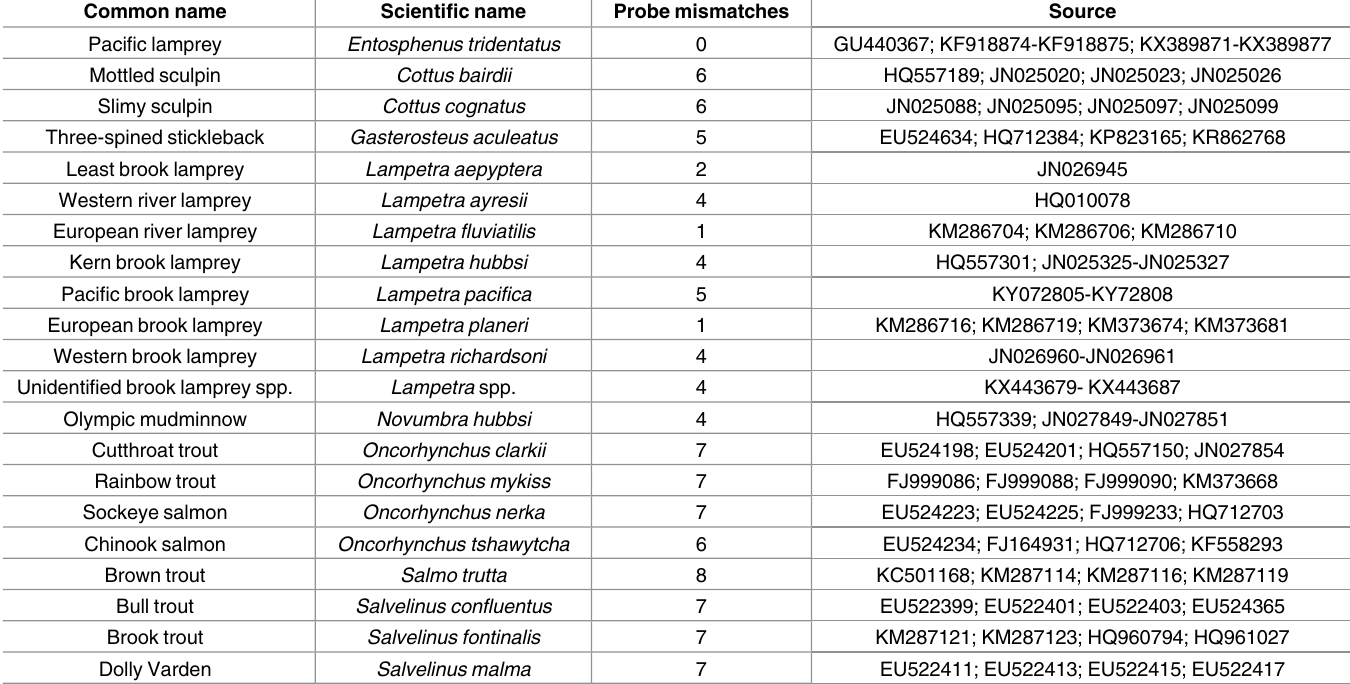
Table 2. Species and source for DNA sequences used for in silico assaydevelopment. Source refers to GenBankaccessionnumberor location of col- lection for specimens analyzedin this study. Probe mismatches refers to the numberof base-pairdifferencesbetweenthe eDNA assay probe and the COI sequencefor a particularspecies. Pacific brook lamprey( Lampetra pacifica )sequencedata were obtainedafter primer and probe